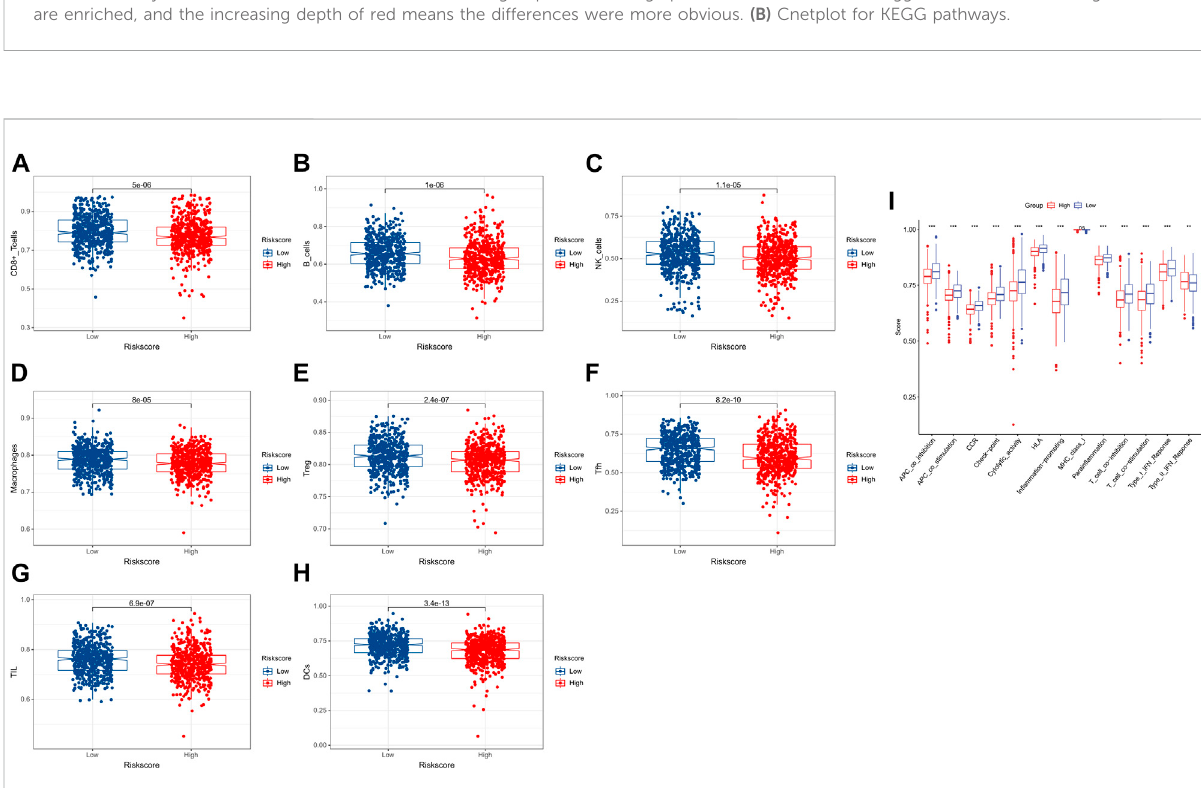
FIGURE 6 Comparison of the ssGSEA scores for immune cells and immune pathways. (A – H) Comparison of the two risk groups for immune cells. (I) Comparison of the two risk groups for immune